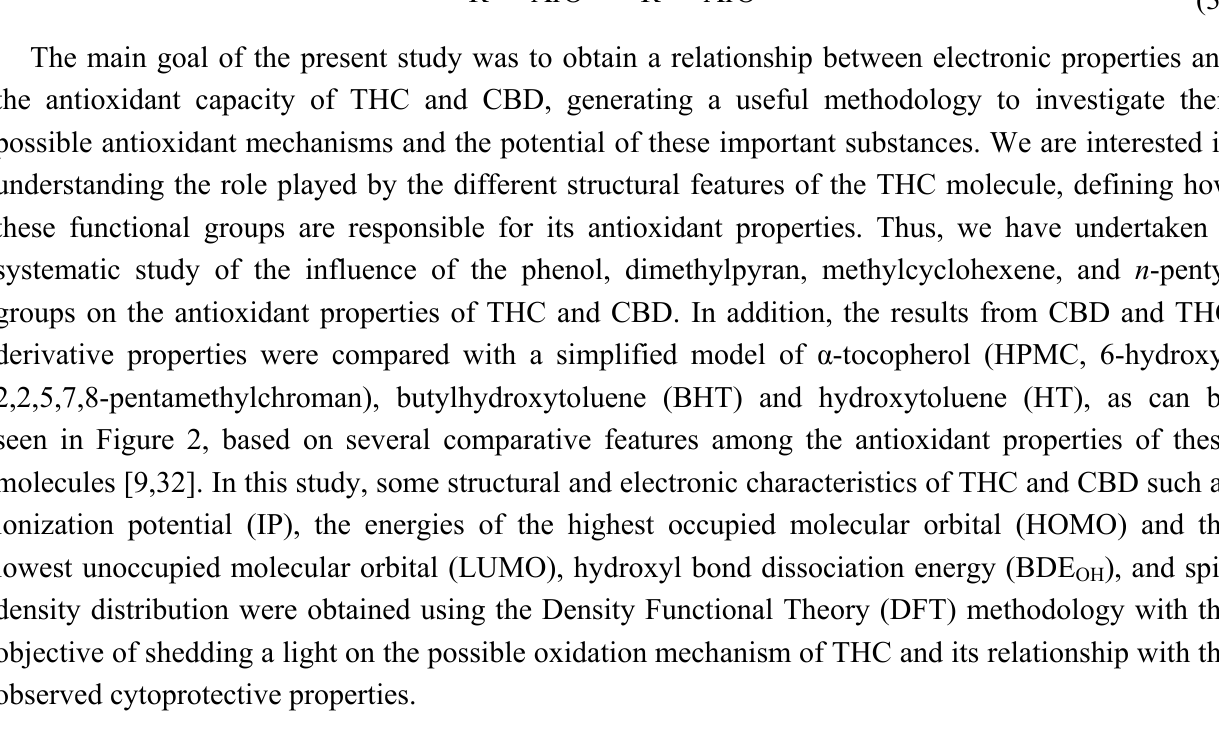
Figure 2. Structure of simplified model of tetrahydrocannabinol (THC) and classical antioxidants.